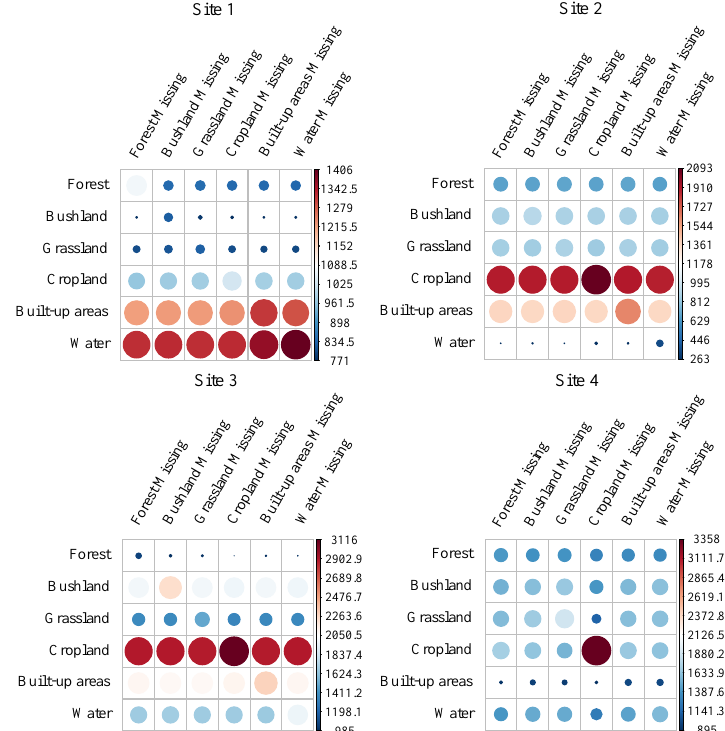
Figure 11. The sensitivity of STIMDR to LULC types when a specific LULC type is missing in the training datasets. The row indicates all the LULC types, and the column indicates the missing LULC type. The color and size of the circle represent the RMSE values (multiplied by 100,000). Larger RMSE are of red color and larger size.